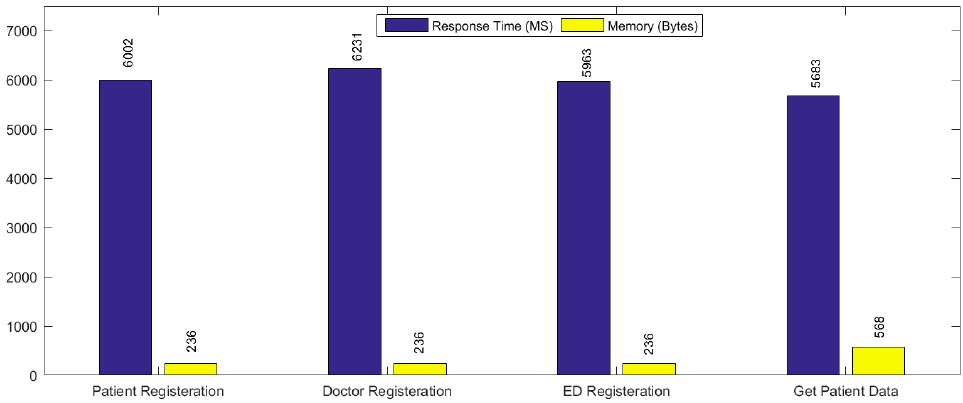
Figure 4. Performance Evaluation of the proposed framework. Table 4. A comparative analysis of the proposed framework vs the state-of-the-art systems. Healthcare